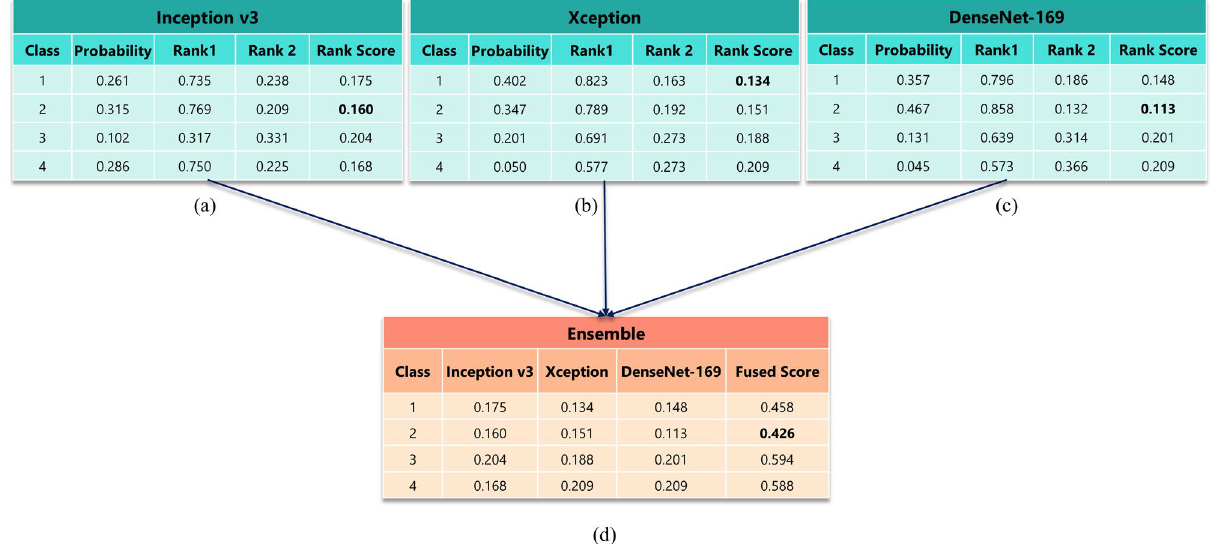
Figure 8. A hypothetical example showing the working procedure of the proposed ensemble model for an image taken from the 4-class dataset. Tables (a–c) show all the necessary calculations required to generate the rank scores from the base learners. Table (d) shows the overall fused score and the final decision to get the classification result. Bold font represents the rank score of the class that is declared the winner by the respective model (image has been made by R.K. using Google